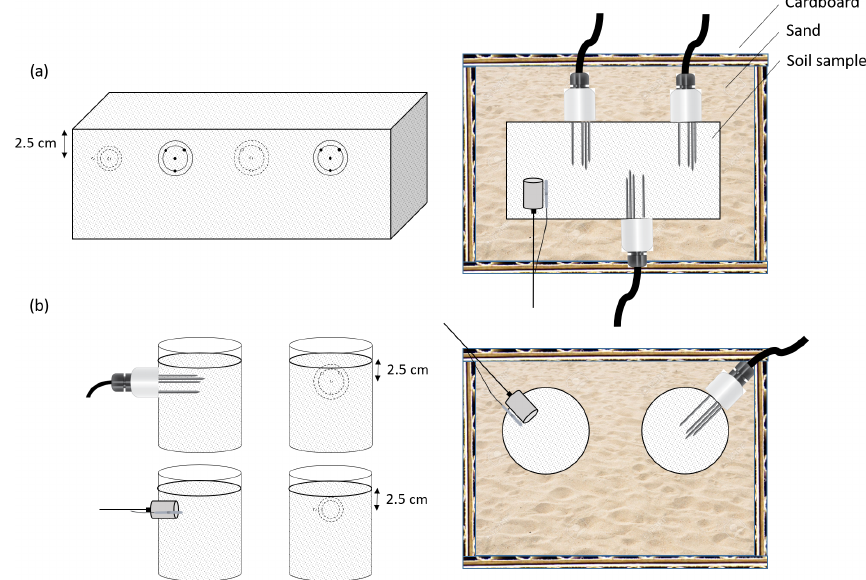
Figure 3. Top view of the cold chamber experimental setup at the University of Guelph (Ontario, Canada) for the fast transition experiment. Setup for (a) the OBS sample (11 × 24 × 12cm for a volume of 3 . 2 × 10 3 cm 3 ) and (b) the Ontario samples (height of 12cm and diameter of 10cm for a volume of 9 . 4 × 10 2 cm 3